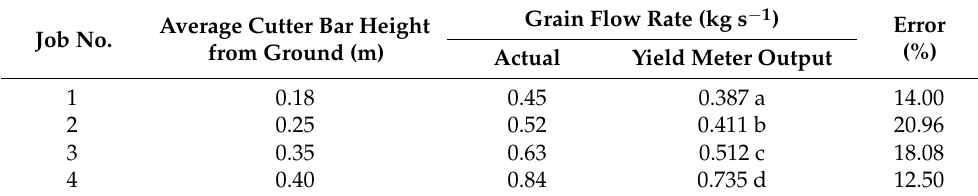
Table 3. Effect of average cutter bar height on yield meter performance.